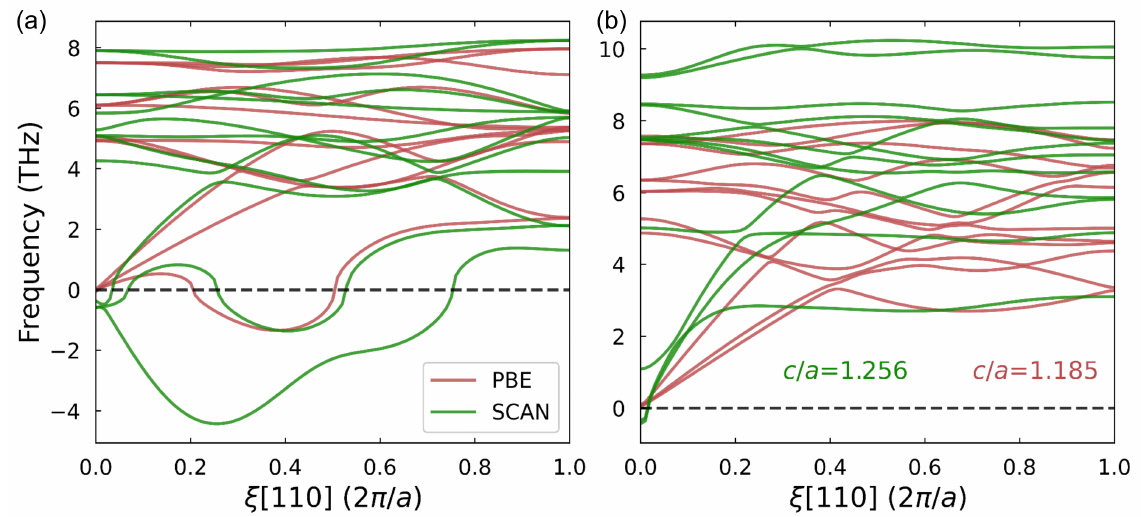
Figure 14. The PBE and SCAN calculated phonon spectra of Ni 2 MnGa in ( a ) the cubic and ( b ) tetrag- onal phases